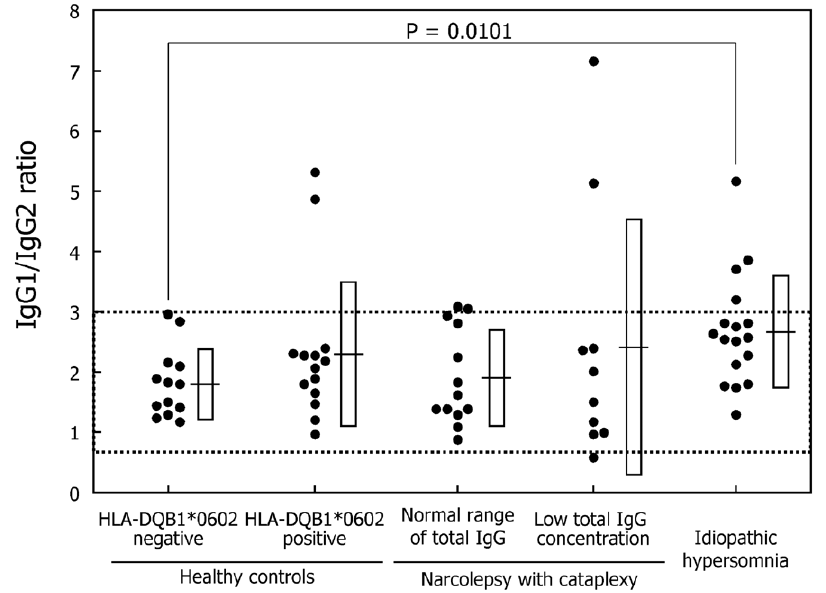
Figure 5. Serum IgG3 level. Definitions of dots, dotted lines, horizontal lines, and squares are provided in the legend for Figure 2.